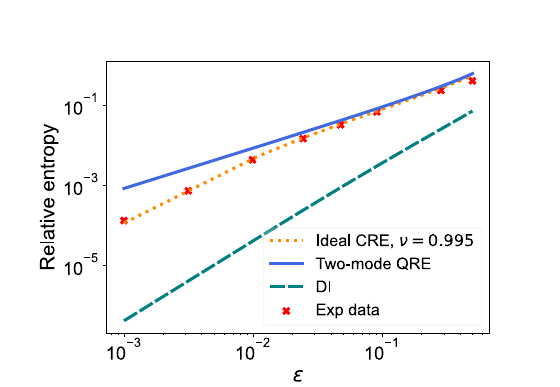
Fig. 6 | Simulatedprobability densityfunction P ð ϕ Þ with ν cos( α ) = 0.981. The probabilitydensityfunctionfor ϕ ,after12740detectioneventsofwhich1478were from detector b .